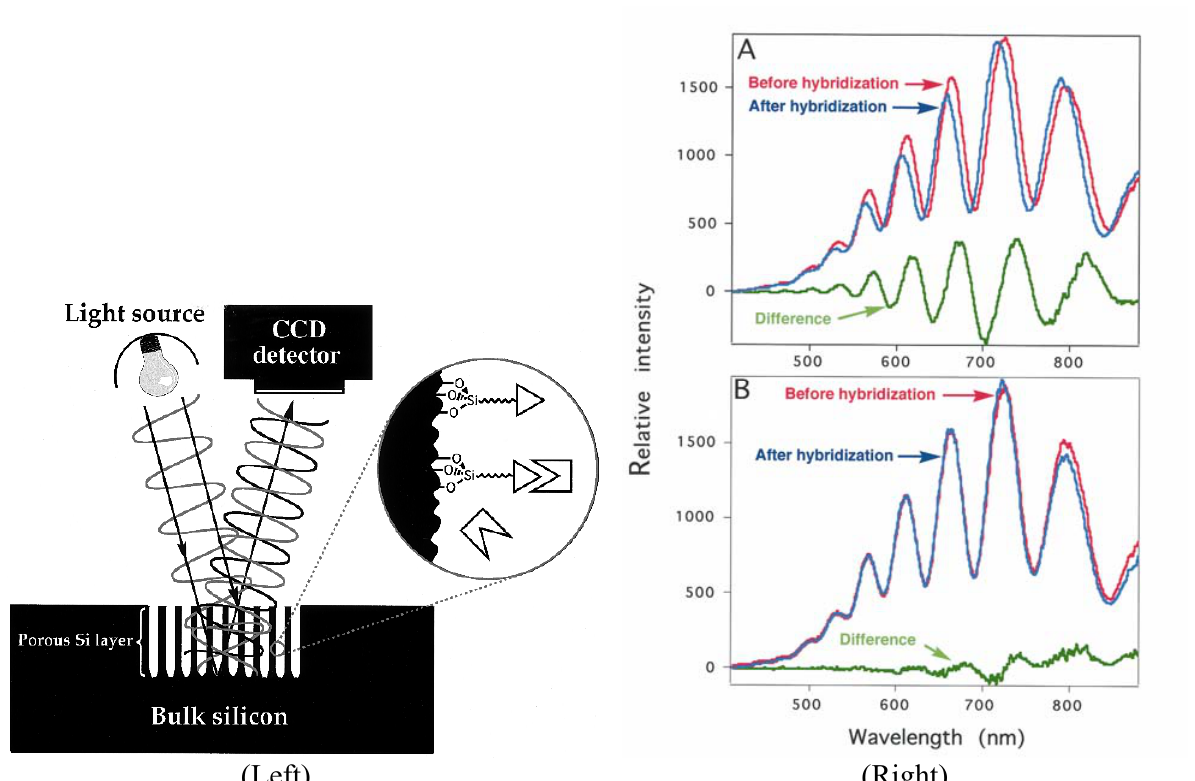
Figure 8. (Left) Schematic of a PS-based optical interferometric biosensor. The silicon oxide surface of the porous layer can be modified to express various molecular recognition elements (such as oligonucleotides, biotin or antibodies). Reflection of white light at the top and bottom of the PS layer results in an interference pattern (Fabry-Perot fringes). Interactions of the molecular species with their recognition partners immobilized on the surface induce a change in the refractive index of the nanocrystalline semiconductor, giving rise to wavelength shifts in the fringe pattern that can be easily detected (charge- coupled device (CCD) camera) and quantified. (Right) Interferometric reflectance spectra of DNA-modified PS layers. Experiments were performed for two DNA sequences and the corresponding complementary strands. For clarity, only one set of data is shown in each case. (A) The Fabry-Perot fringes from a PS surface derivatized with DNA-A (“before hybridization,” red trace) shift to shorter wavelength upon exposure to a 2 × 10 -12 M solution of DNA-A ’ (the cDNA sequence to DNA-A) in 1 M NaCl(aq) (“after hybridization,” blue trace). The net change in effective optical thickness (from 7,986 to 7,925 nm) upon DNA-A ’ recognition is represented by the difference between the two interference spectra (“difference,” green trace). (B) The control experiment, showing the Fabry-Perot fringes of a DNA-A–derivatized PSi surface before and after exposure to a 2 × 10 -12 M solution of DNA-B (non-cDNA sequence) in 1 M NaCl(aq). No wavelength shift was observed up to the measured concentration of 10 - 9 M DNA-B. Reproduced from [42].